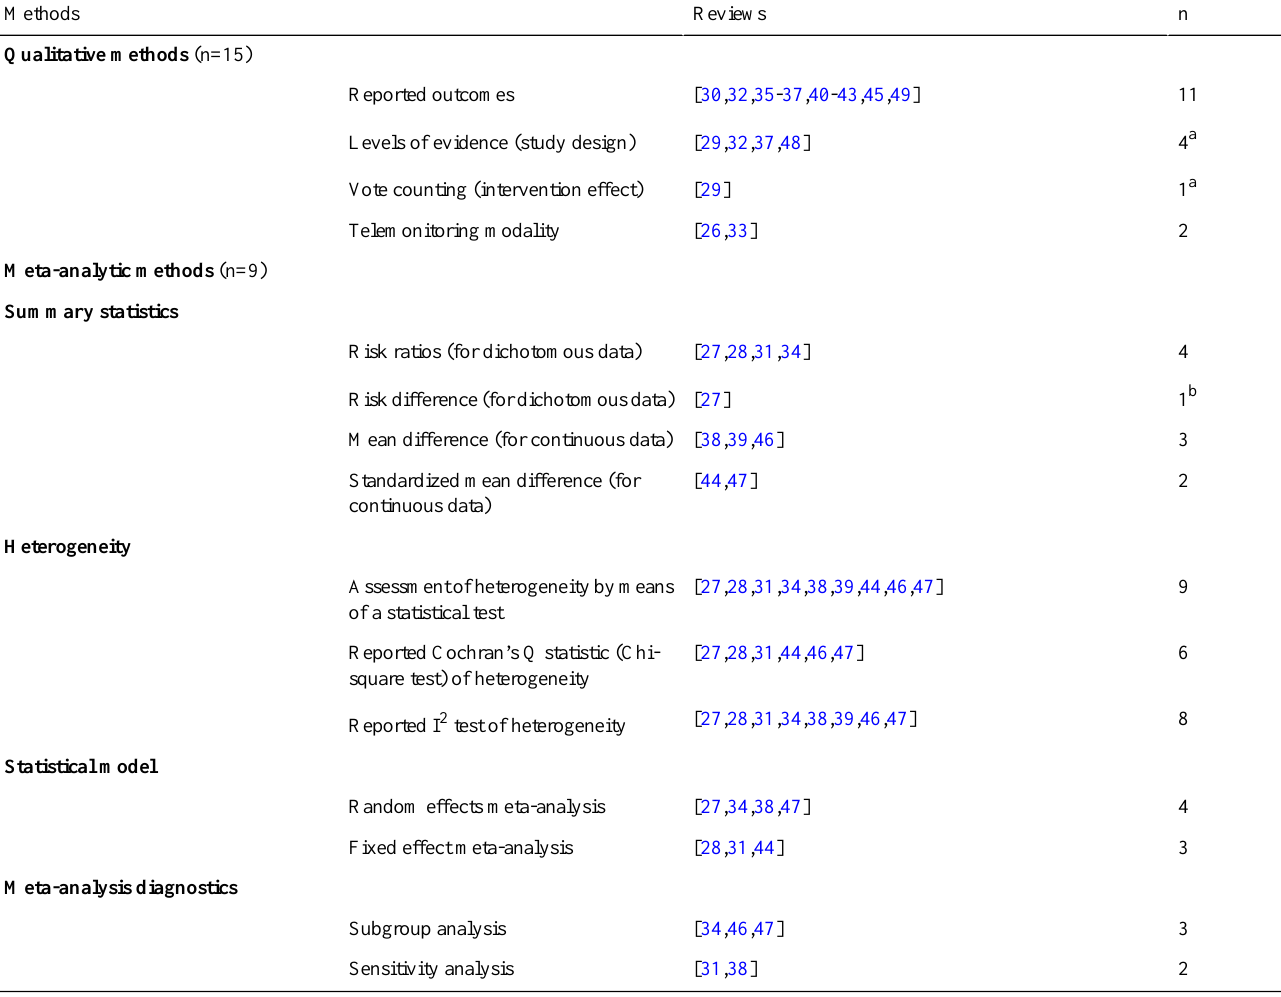
Table 5. Methods used in SRs and MAs to synthesize the available evidence from the primary